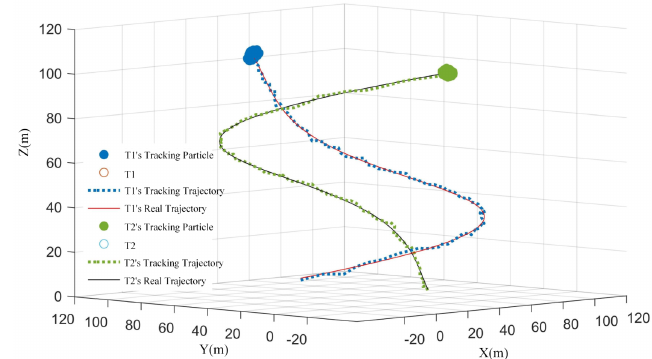
Figure 6. Trajectories of targets’ tracking in 3D